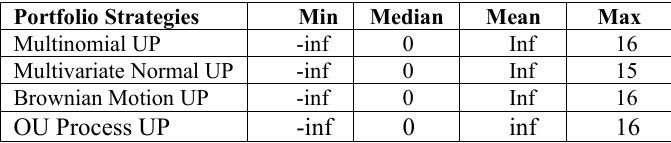
Table 4. Long term duration data analysis (12 years duration).